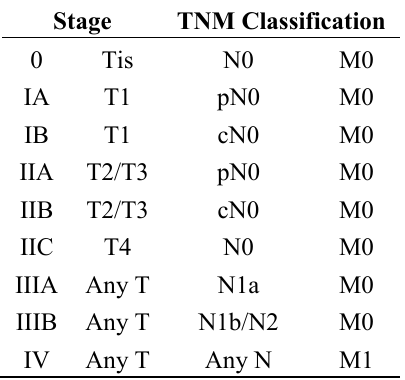
Table 2. AJCC 2010 staging for Merkel Cell Carcinoma